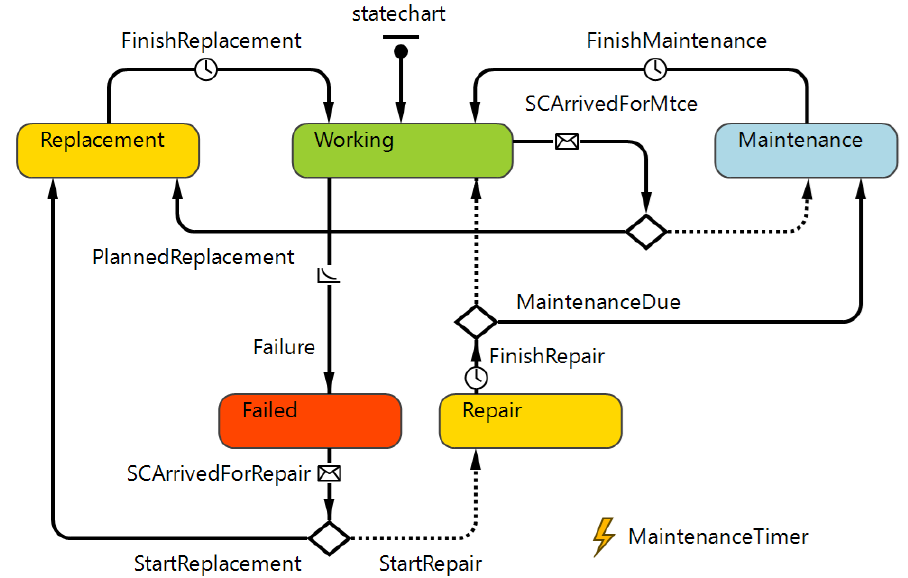
Figure 3. Statechart showing the different possible states of the borehole units, the transitions between states, and the places of decision (lozenge-shaped symbols) (from Borshchev pp. 180, [6]).